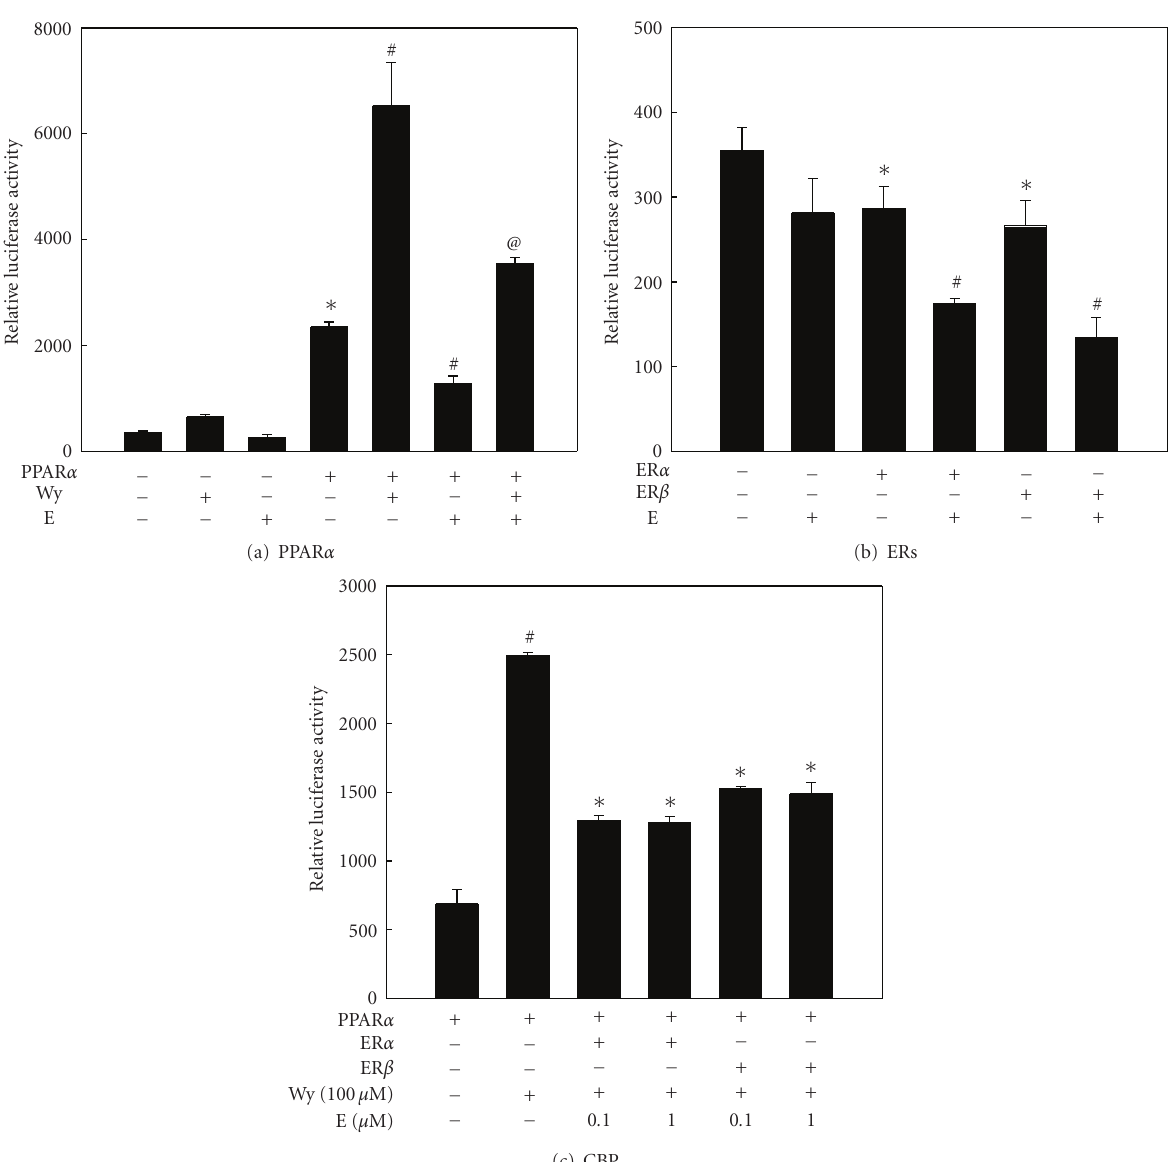
activity to a greater extent than estrone or estriol.